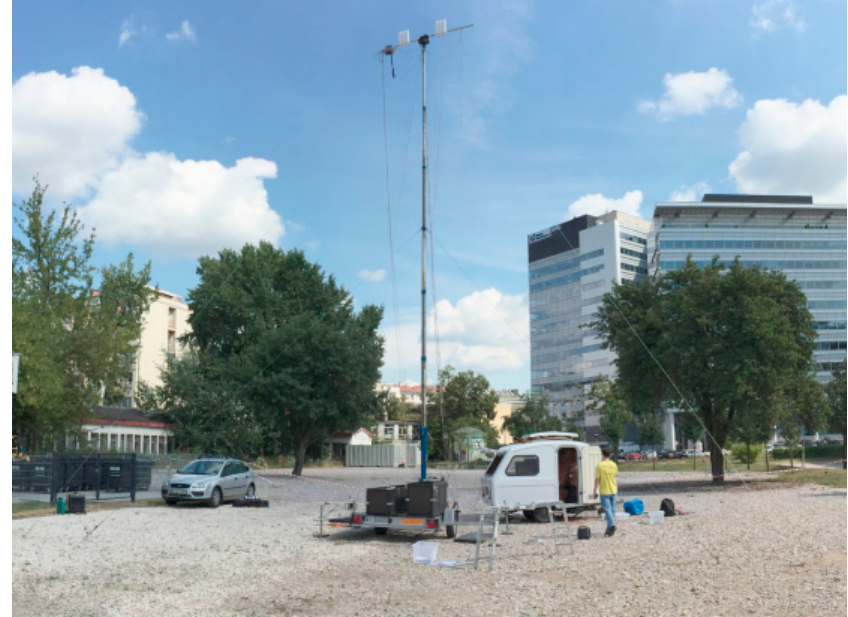
Figure 11. The radar demonstrator during measurement experiment.